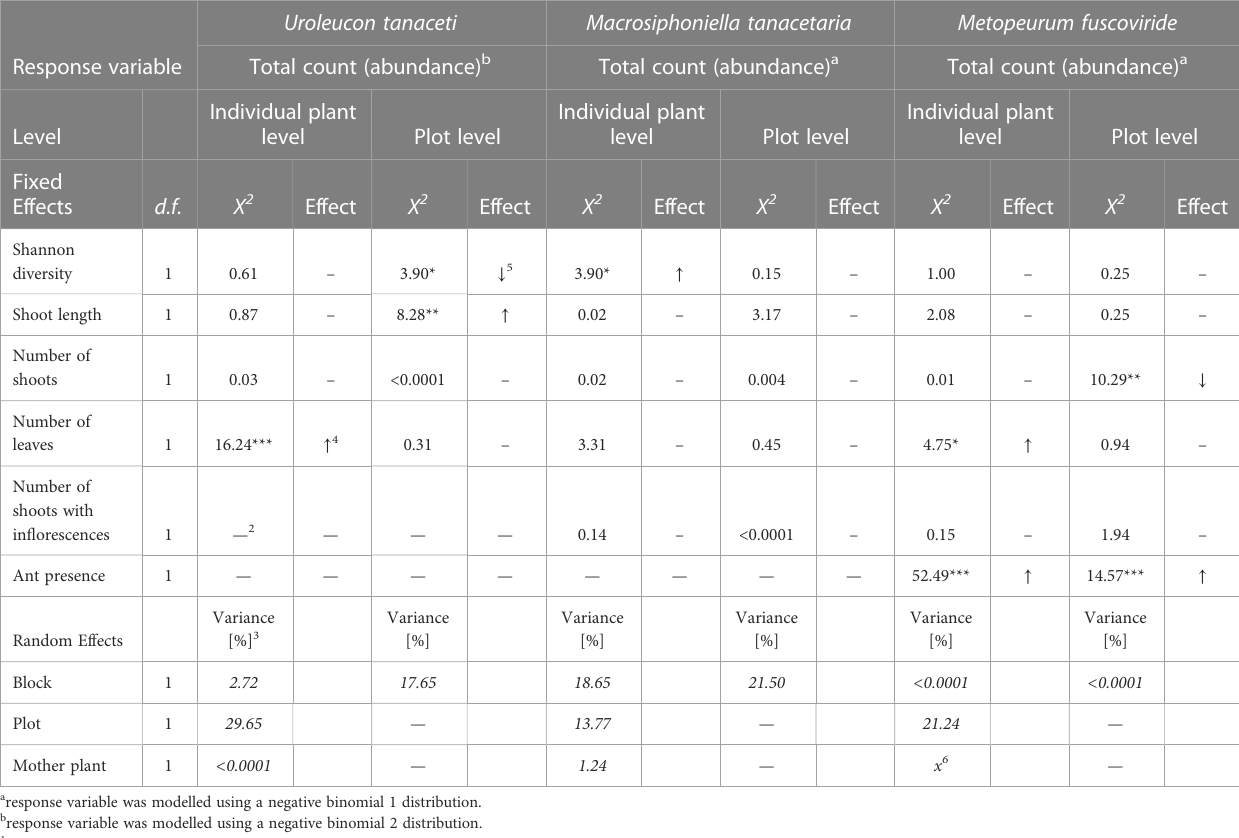
TABLE 3 GLMM-estimates of total count (winged + unwinged morphs) of aphid species specialised on Tanacetum vulgare in calendar week 25 of